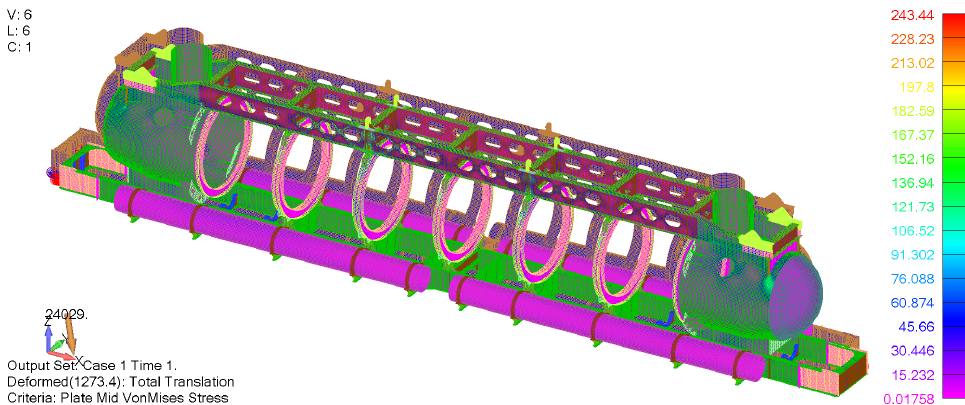
Figure 19. Mid-plate von Mises stresses for launching/recovering in rough seas.